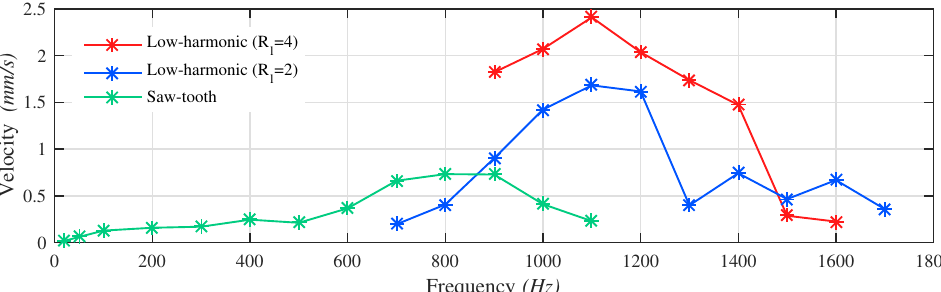
Figure 12. The average output velocity vs. the driving frequency in two types of waveforms. Each value of every average output velocity point is calculated from 3–5 sets of displacement